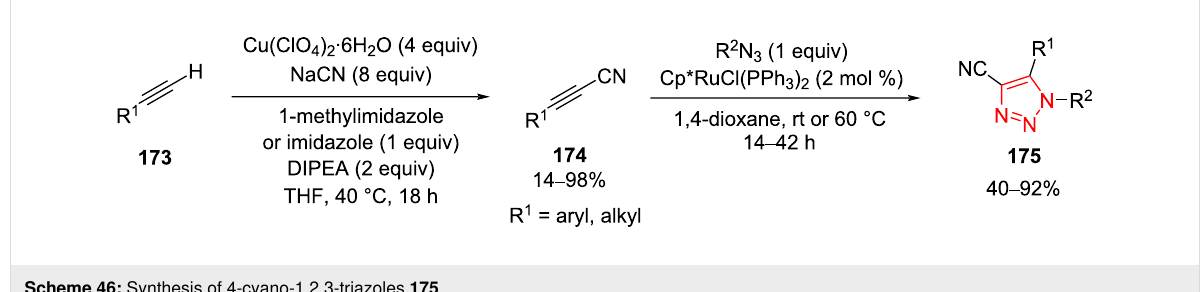
Scheme 46: Synthesis of 4-cyano-1,2,3-triazoles 175 .